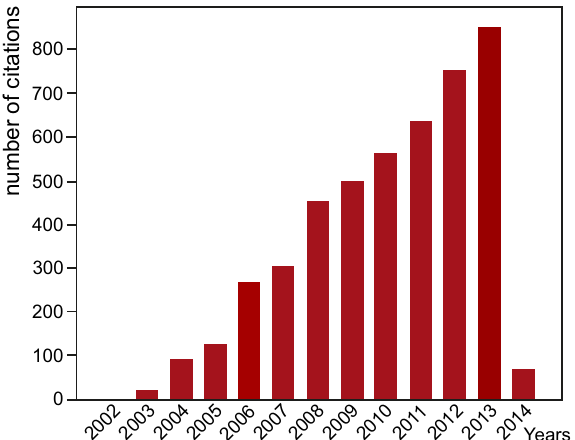
Figure 3. Number of citations per year (source: Web of